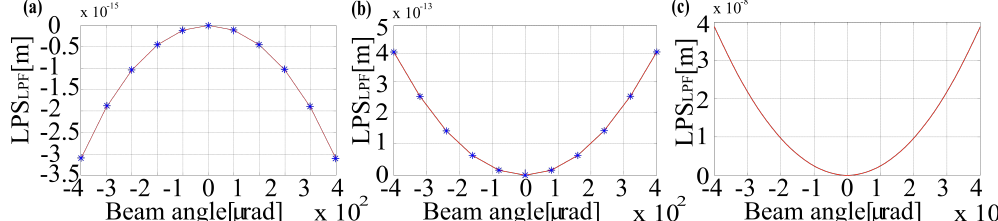
Figure 3. Numerically computed LPS LPF results for interference of the diffracted flat-top beam with ( a ) a non-diffracted Gaussian beam and ( b ) a diffracted Gaussian beam. The analytically result LPS LPF obtained when both beams are non-diffracted is shown in ( c